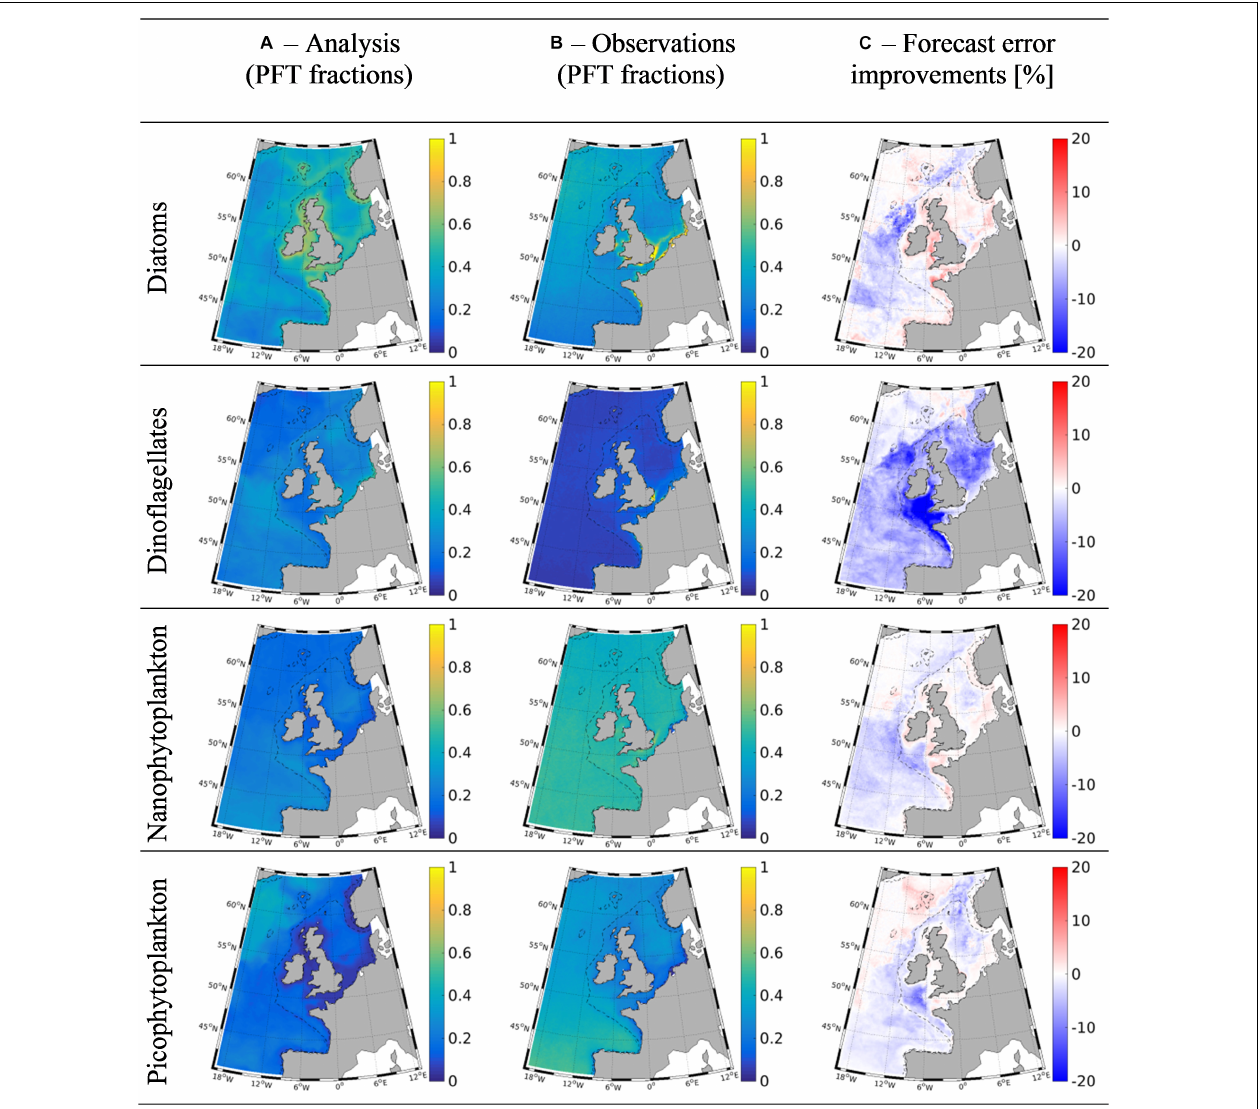
FIGURE 8 | Improved simulation of the plankton community structure by assimilating ocean-colour plankton functional type (PFT) products into a marine ecosystem model of the North East Atlantic. Column (A) PFTs fractions from the assimilative simulation (i.e., ratio of the PFT chlorophyll to the total chlorophyll); (B) PFTs fractions from ocean-colour data; and (C) percentage difference between the RMSD of the PFT assimilation (1-month forecasts) and of the reference model simulation without assimilation; RMSD is the root-mean-square-deviation between grid-point time series of model output and ocean-colour data. Figure elaborated from Figure 8 in Ciavatta et al. (2018), delivered by the Copernicus Marine Environment Monitoring Service TOSCA